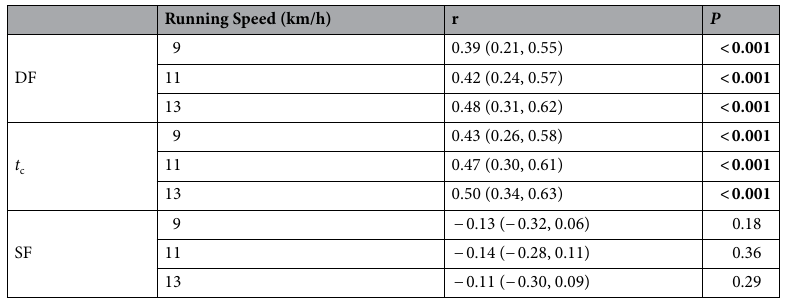
Table 3. Pearson’s correlation coefficients ( r ) and the corresponding 95% confidence intervals (lower, upper) and P -values for the relationships between the foot-strike angle and duty factor (DF), contact time ( t c ), and stride frequency (SF) for three tested speeds. The statistically significant correlations ( P ≤ 0.05) are indicated in bold font.